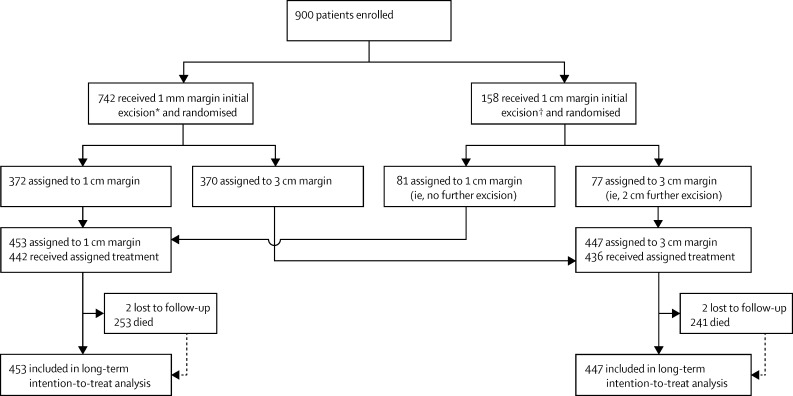
Trial profile*Initial excision by the proposed pathway. †Initial excision by the alternative pathway.